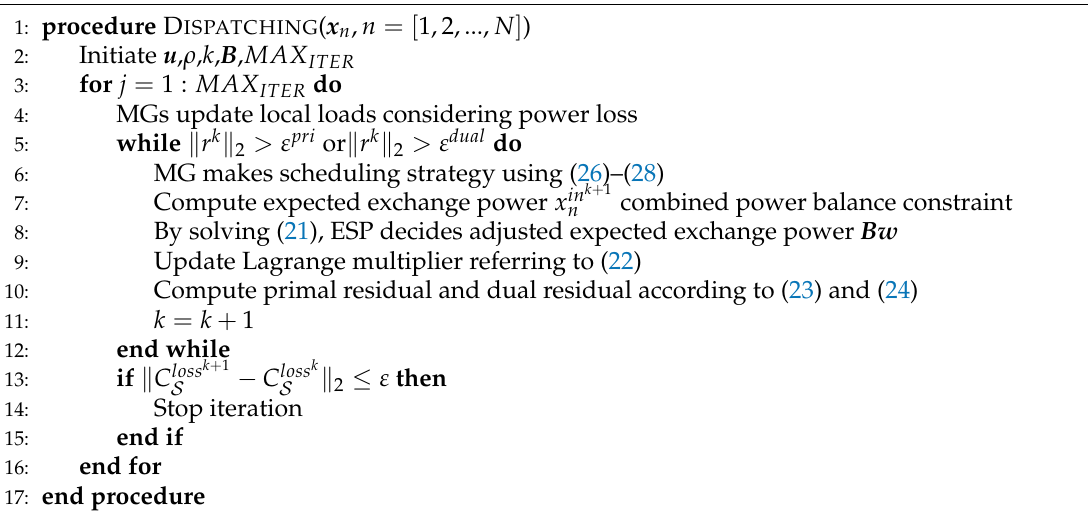
Algorithm 1 Distributed optimal dispatching